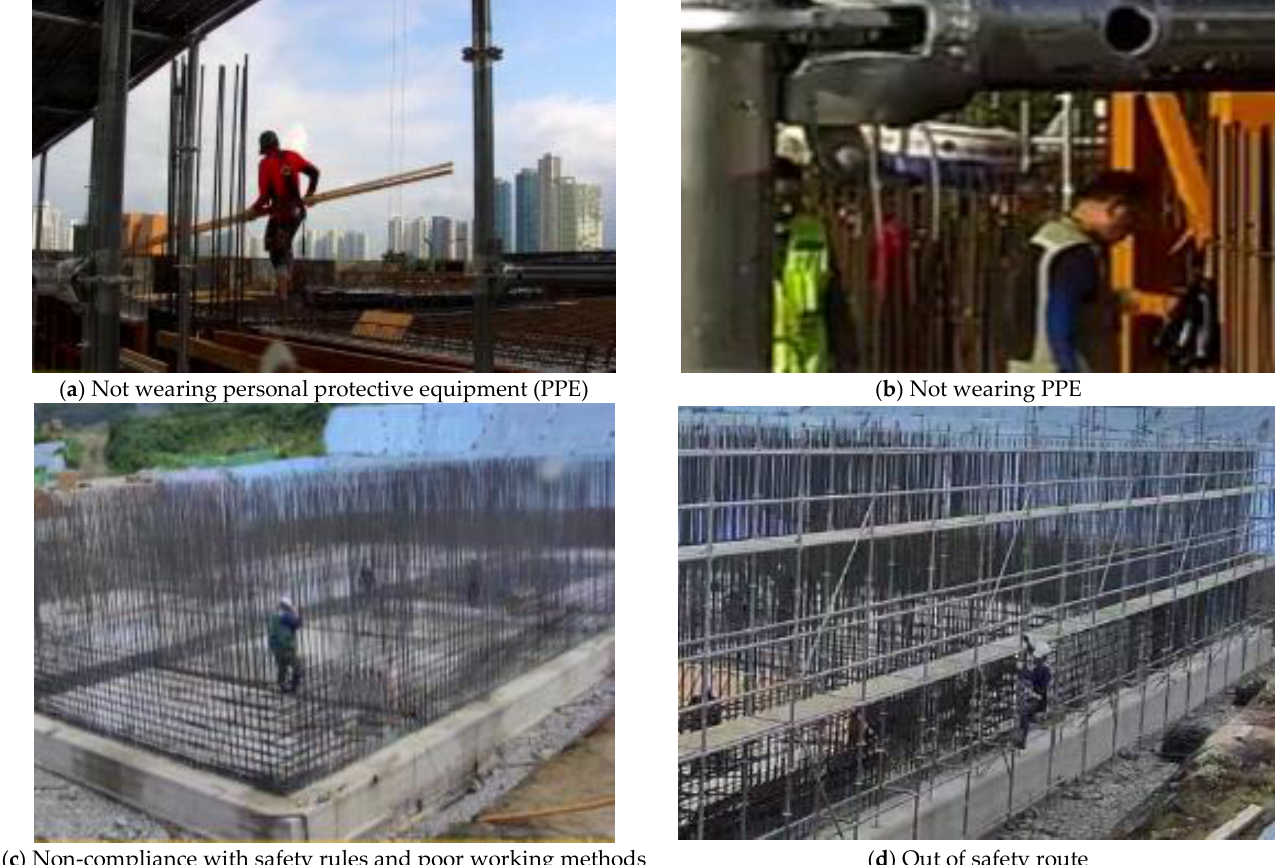
Figure 14. Problems of small- and medium-sized sites identified through CCTV.